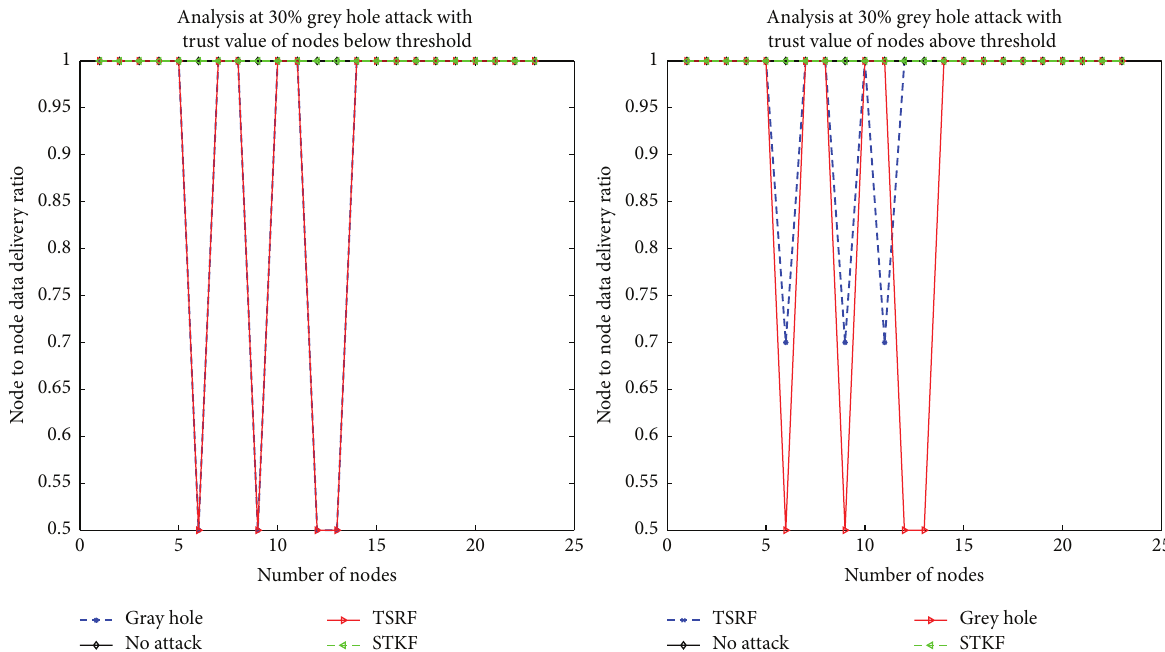
Figure 6: Graphs representing effect of trust value on the performance of TSRF and STKF routing protocols when trust value of nodes is below and above